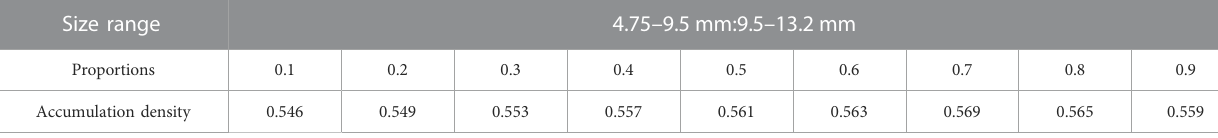
TABLE 1 ccumulation densities of binary